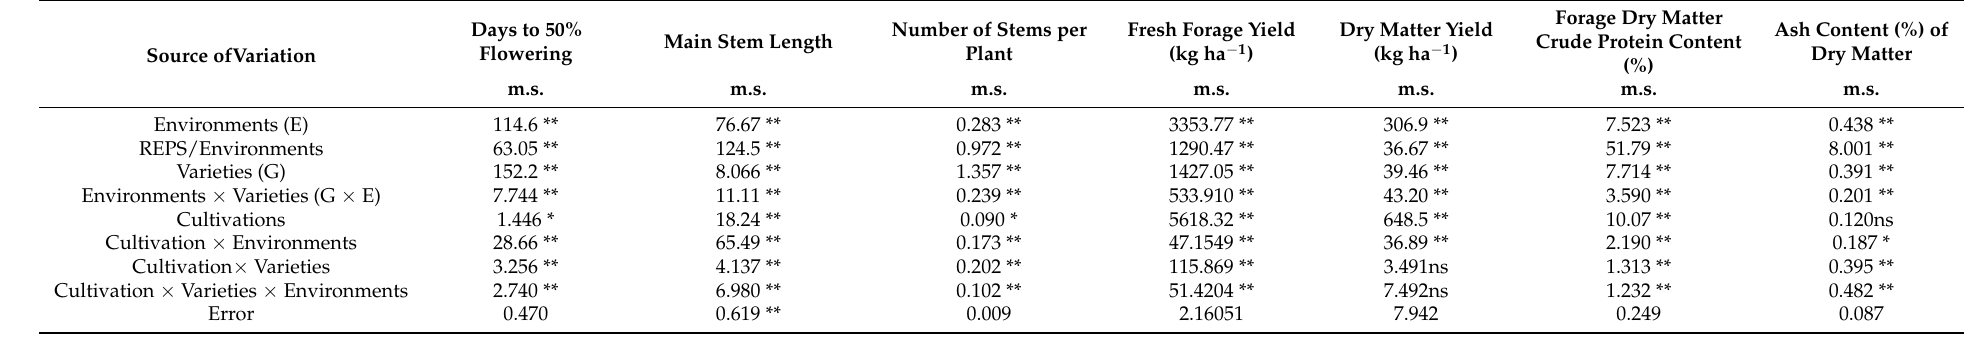
Table 1. Mean squares (m.s.) from analysis of variance over environments and cultivation methods for tested traits: days to 50% flowering, main stem length, number of main stems per plant, fresh forage yield (kg ha − 1 ), dry matter yield (kg ha − 1 ), forage dry matter crude protein content (%) and ash content (%) of dry matter.